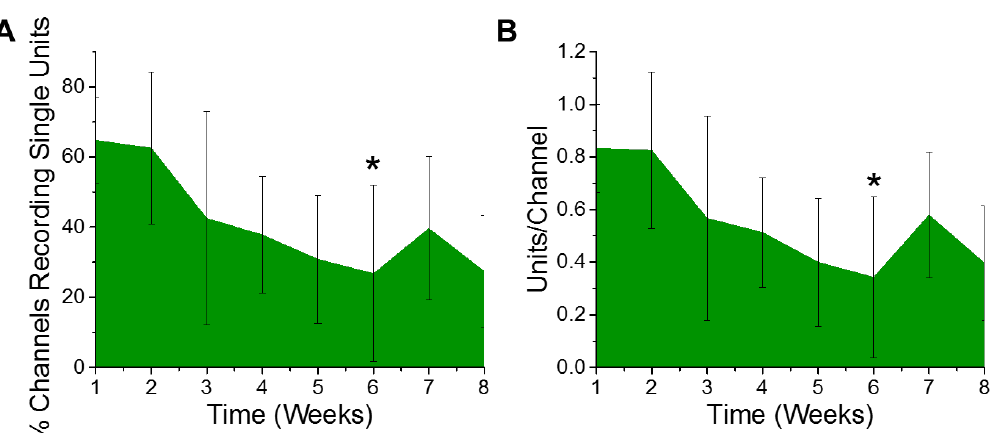
Figure 1. Electrophysiological recordings change over time. There was a significant decrease in recorded ( A ) % channels recording single units (* p = 0.05) and ( B ) units per channel between the first- and sixth-week post implantation (* p = 0.03). n = 6.